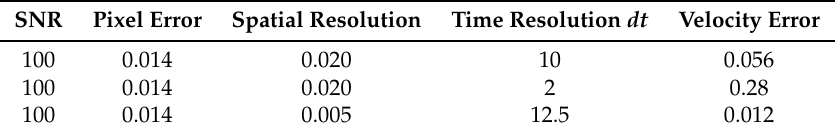
resolution also changes the size of a particle on the image